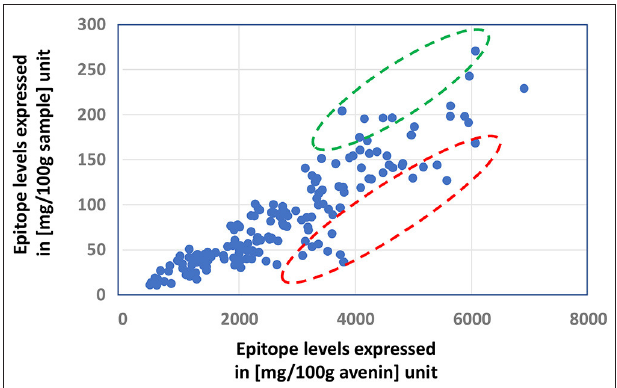
FIGURE 2 | Demonstrating the importance of expression levels of avenin and non-avenin proteins in the ranking of relative celiac epitope amounts of oat samples by the comparison of ranking samples based on the amount of celiac-related epitopes expressed in (mg/100 g avenin) and (mg/100g sample) units. Relative celiac-related epitope levels in samples in the red circle are largely underestimated by the simple comparisons of the epitope levels in the samples, not taking into account the total protein content and its avenin content. Circled data with red and green indicate under- and overestimated epitope levels using [mg/100 g avenin] units, respectively, not considering the contribution of protein content and avenin content of the